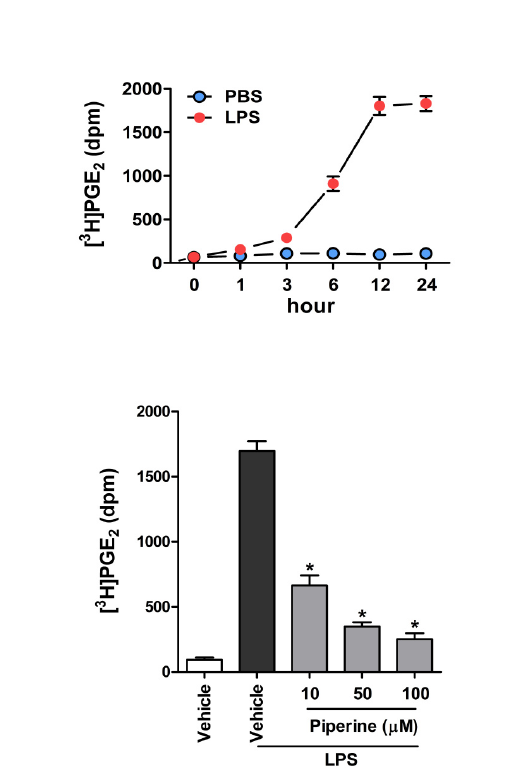
Figure 2. Piperine inhibited the generation of PGE and PGD in LPS-stimulated 2 2 RAW264.7 cells. [ 3 H]AA-labeled cells were treated with 1 μ g/mL LPS (red circles) or PBS ( a ) (blue circles), and an evaluation of the time-course of LPS-induced generation of PGE 2 and PGD ( b ) was performed by quantifying the radioactivity signal of metabolites. [ 3 H]AA- 2 labeled cells were treated with piperine (gray bars) or vehicle (DMSO, white and black bars) for 24 h, and stimulated with 1 μ g/mL LPS for 12 h. We measured the radioactivity signal ( c ) and [ 3 H]PGD ; ( d ). Data are expressed as means ± S.D. of corresponding to [ 3 H]PGE 2 2 three separate experiments. * p < 0.05 vs. vehicle controls (black